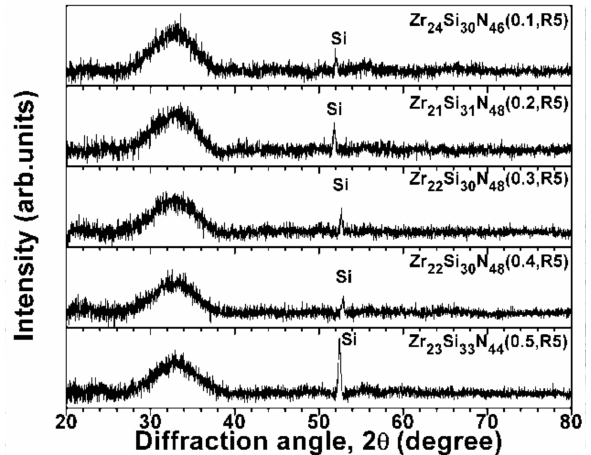
Figure 1. XRD patterns of as-deposited Zr–Si–N coatings prepared on Si substrates using various (N 2 /(N 2 + Ar)) flow ratios, a substrate holder rotation speed of 5 rpm, and sputter powers of W Zr = 100 W and W Si = 100 W.